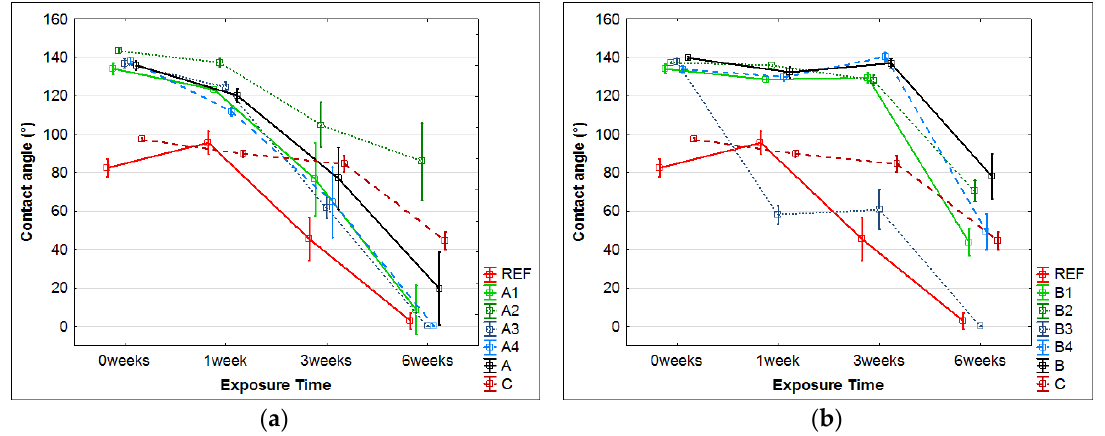
Figure 6. Changes in the contact angle of tested coatings during 6 weeks of artificial weathering. REF: native untreated oak wood; A: oak wood with the nano-based hydrophobic coating; B: oak wood with the hydrophobic coating with wax additives; 1, 2, 3, 4: the types of oak wood surface treatments; C: oil-based coating. ( a ) Decreasing of hydrophobicity of hydrophobic coating (A) with different surface treatments of oak wood (No. 1–4—see Tables 1 and 2); ( b ) Decreasing of hydrophobicity of hydrophobic coating (B) with different surface treatments of oak wood (No. 1–4). Comparison with untreated oak wood (REF) and oil-based coating (C) is shown.